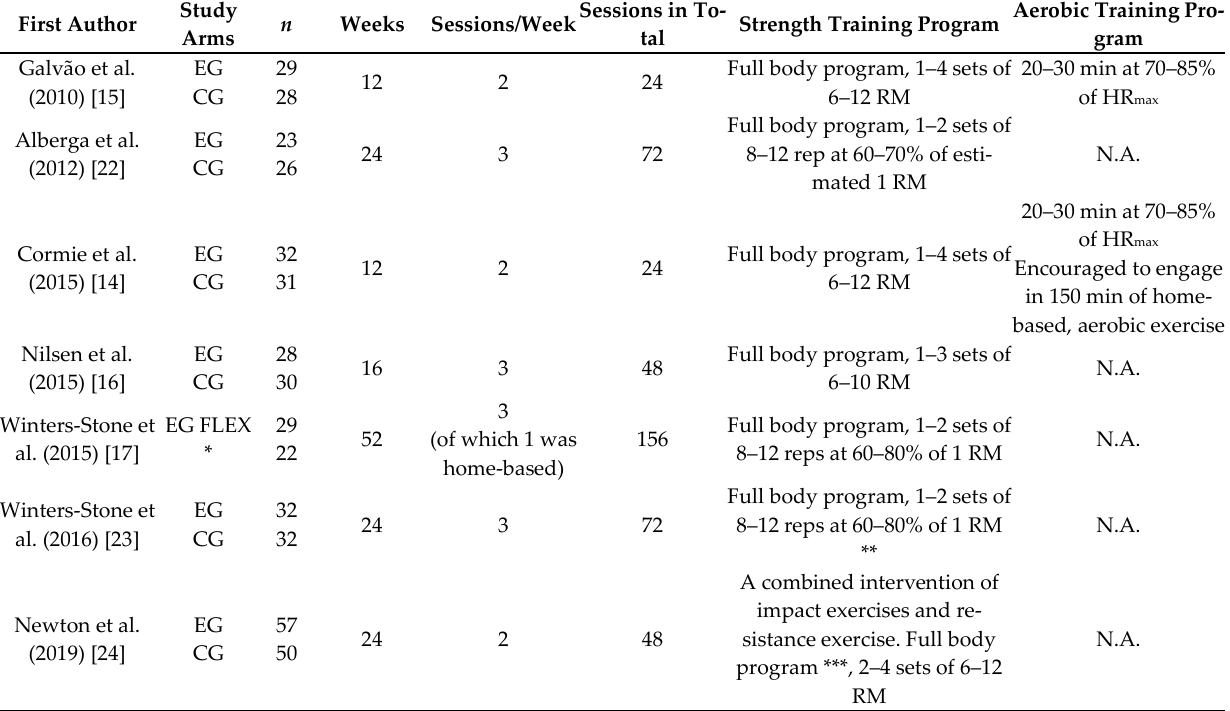
Table 1. Study characteristics in prostate cancer